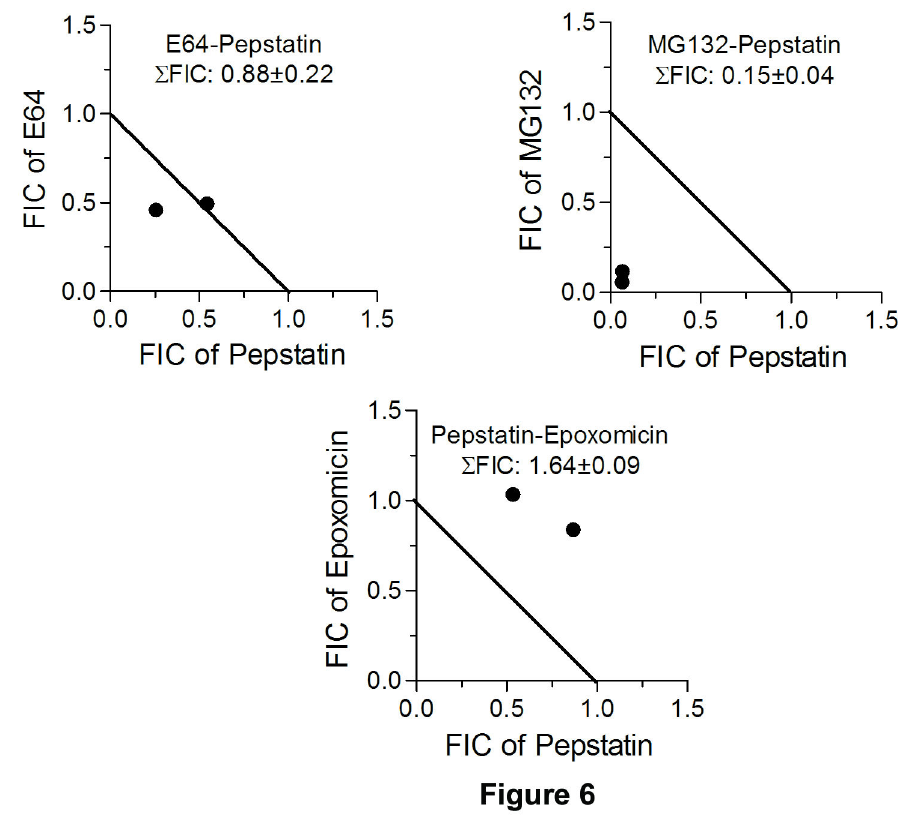
Figure 6. See figure 5 for legend. The isobolograms indicate additive, synergistic, and antagonistic antiparasitic effects of E64- pepstatin, MG132-pepstatin, and epoxomycin-pepstatin combinations, respectively.